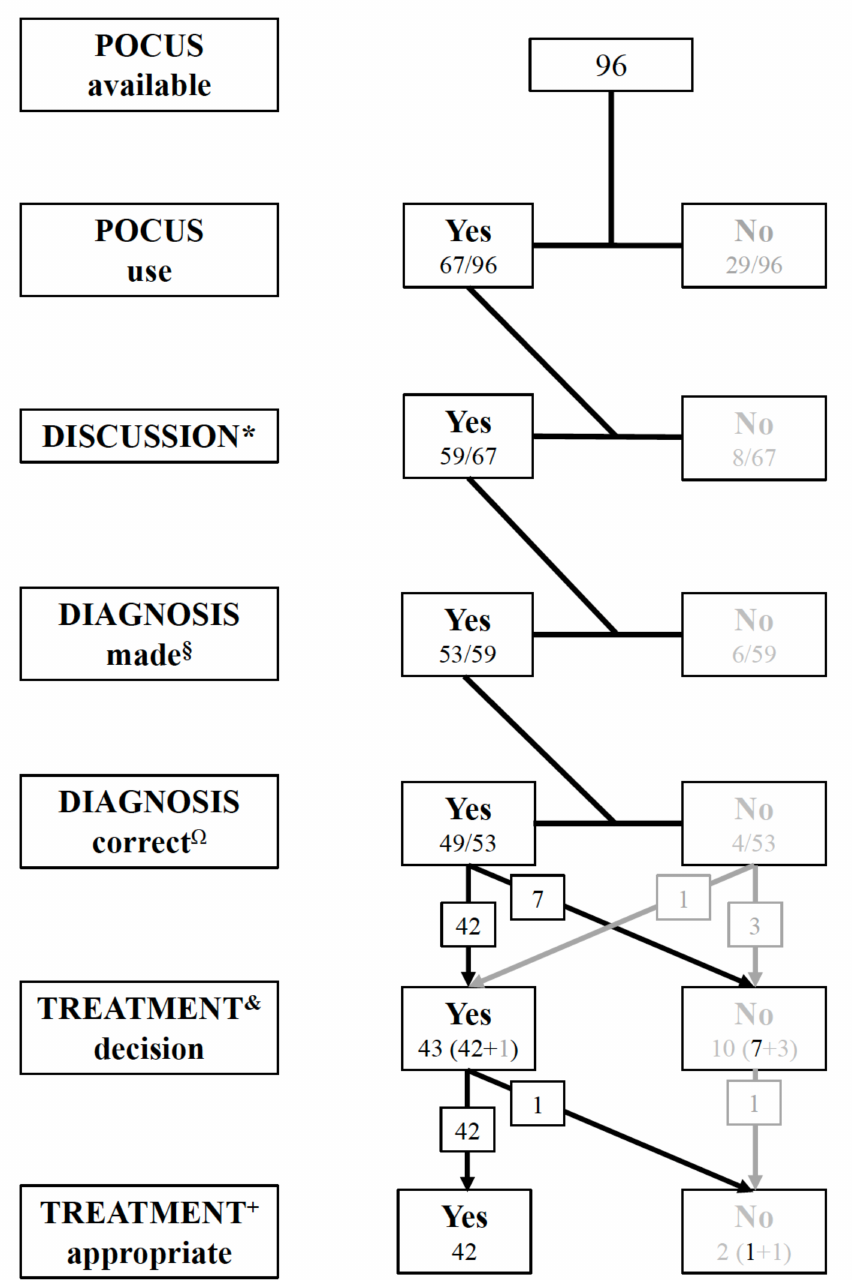
Figure 4. Flow chart on POCUS use among the 96 teams of the POCUS group: * Discussion = any utterance/statements relating to POCUS interpretation; § Diagnosis made = explicit statement of a POCUS-derived diagnosis; Ω Diagnosis correct = statement of pulmonary embolism OR right ventricular dilatation (teams randomized to embolism loop) and pericardial tamponade (teams randomized to tamponade loop); & Treatment decision = explicit statement of a treatment decision; + Treatment appropriate = thrombolysis OR no specific treatment (teams randomized to PE loop) and pericardiocentesis (teams randomized to PT loop), respectively; Inappropriate treatment sub summarized all treatment decisions not fulfilling the above definition of